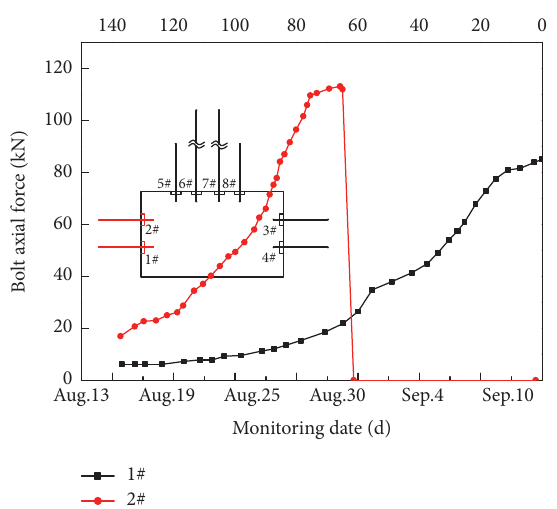
Figure 17: Hydraulic fracturing section: stress of side bolt of coal pillar at 2# station.